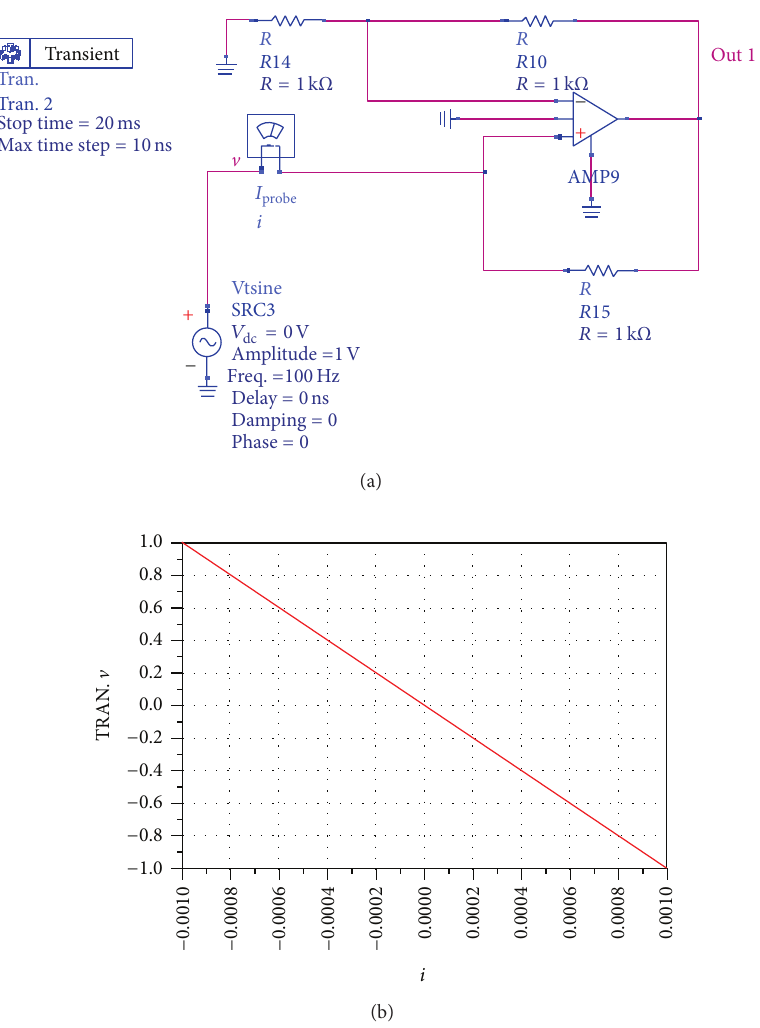
Figure 9: (a) Negative resistance convertor; (b) V − 𝑖 characteristic of negative resistance